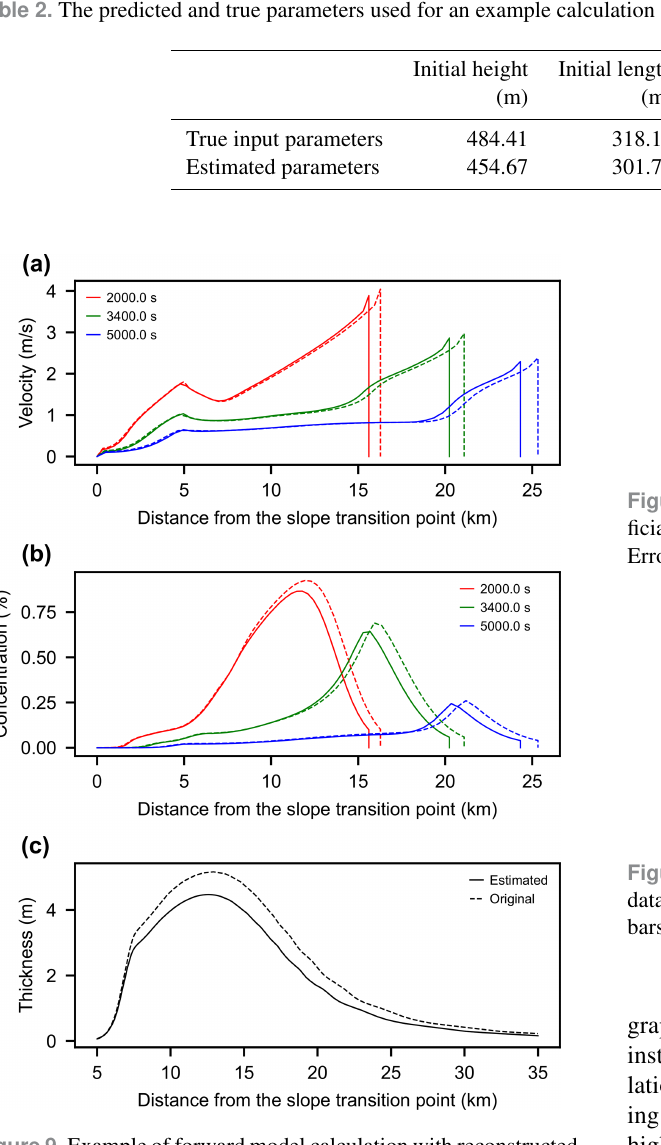
Figure 9. Example of forward model calculation with reconstructed and true parameters. The solid line indicates the calculation result using the predicted parameters, and the dashed line exhibits the re- sults using the true parameters. (a) Velocity distribution at 2000, 3500, and 5000 seconds after the flow initiation. (b) Total sediment concentration at 2000, 3500, and 5000s after the flow initiation. (c) Spatial distribution of bed thickness at 25000s after the flow initiation.